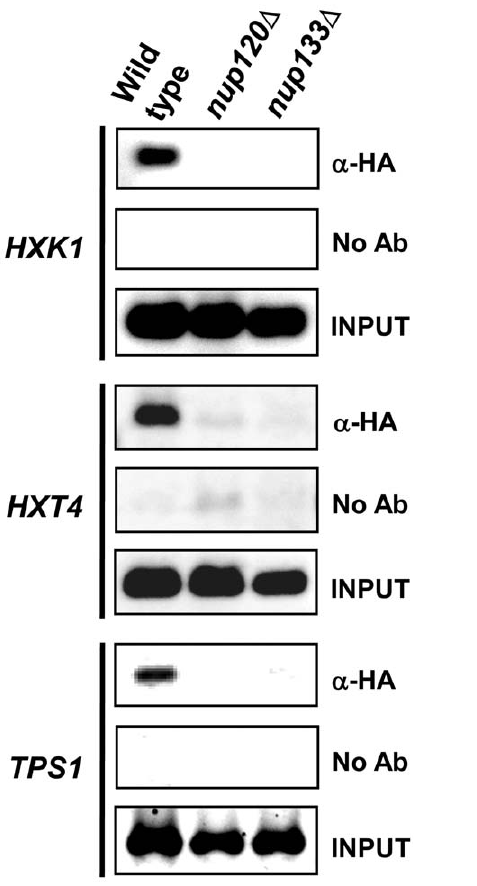
Figure 7. Deletion of NUP120 or NUP133 eliminates Mig1 binding to additional target promoters. HA-tagged Mig1 ( a -HA) was immunoprecipitated from wild type, nup120 D , and nup130 D cells grown in the presence of glucose. PCR was used to amplify the promoters of HXK1 , HXT4 , and TPS1 from immunoprecipitated material ( a -HA), no antibody negative control (No Ab), and whole cell extracts (Input).